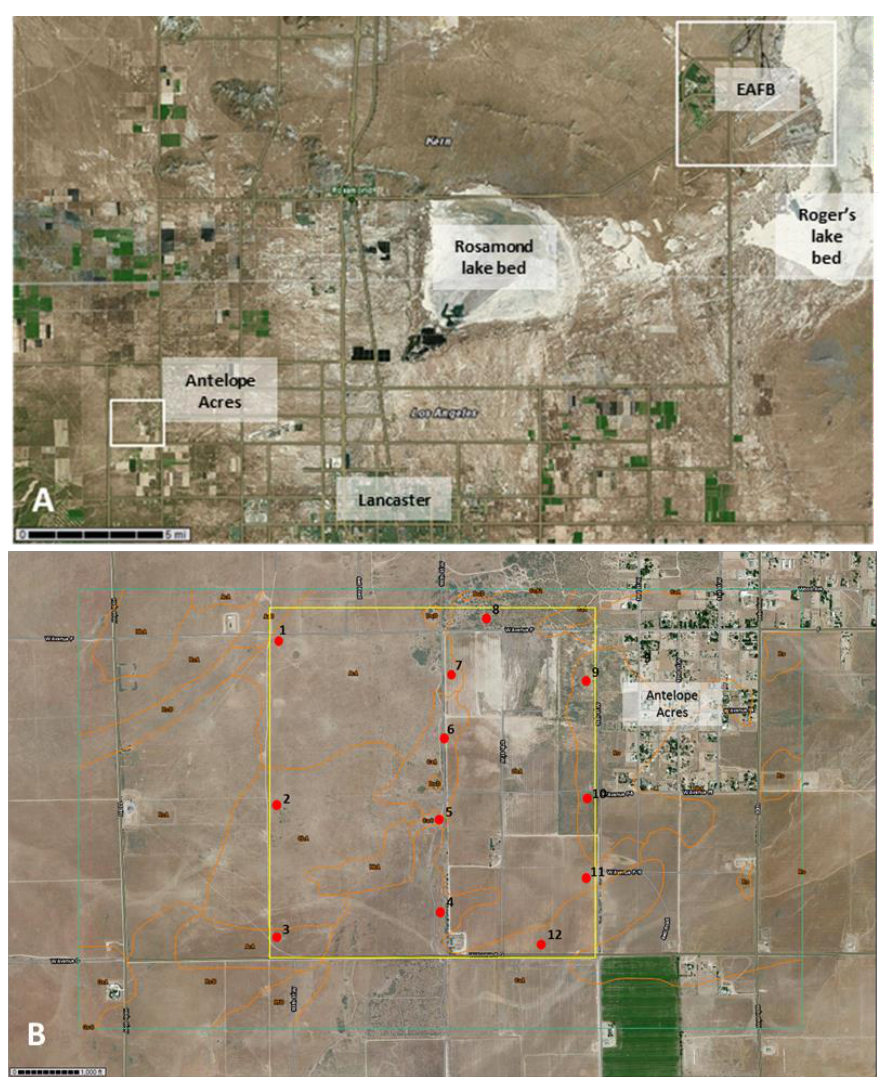
Figure 3. Sampling area in the western Mojave Desert where EAFB is located (upper right corner within the white square). Rosamond dry lakebed (center) and Roger’s dry lakebed (upper right) can be seen. The sampling location is indicated with a smaller white square southwest of Rosamond dry lakebed ( A ). The sampling area west of Antelope Acres with individual sampling locations are indicated as red dots ( B ). Several subsamples were collected at each indicated sampling site. Orange lines indicate borders of different soil types (United States Department of Agriculture (USDA) websoilsurvey (WSS) database).